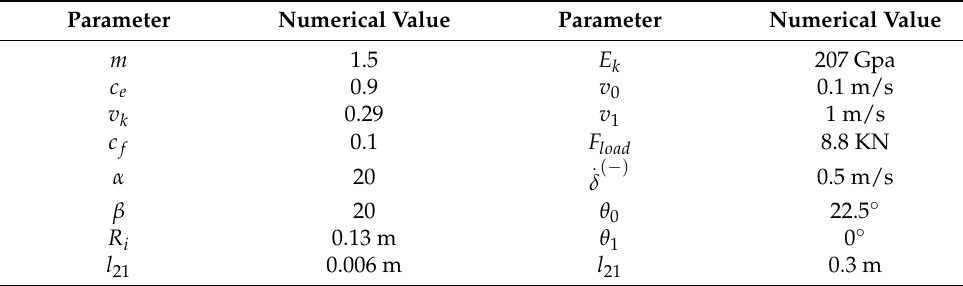
Table 2. Dynamic simulation